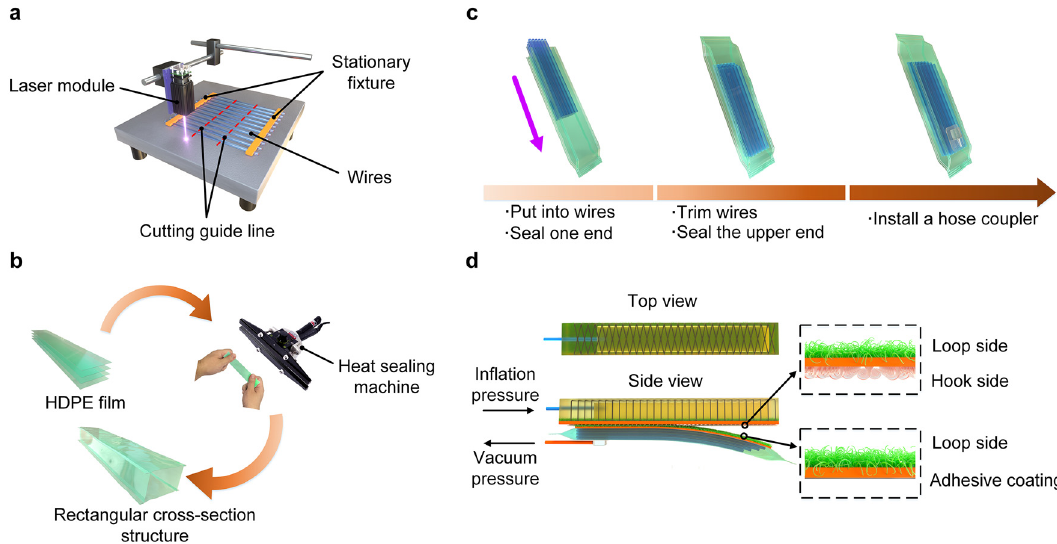
Figure 3. Fabrication processes of the wire jamming structure. ( a ) Illustration of cutting process of wires. ( b ) Heat sealing process of rectangular cross-section structure using HDPE films (film thickness 0.08 mm). ( c ) Assembly process of trimmed wires and airtight envelope. ( d ) Illustration of the soft pneumatic actuator based on wire jamming structure, including local details of double-sided Velcro strip and knit loop fastener with pressure-sensitive adhesive.